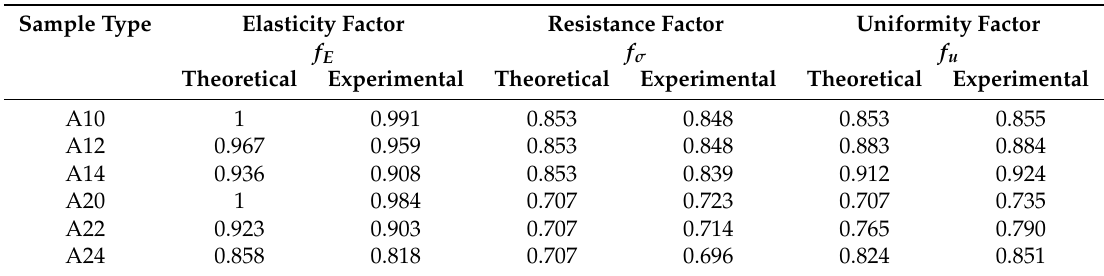
Table 4. Quality factors for composites reinforced by type “A” fabric.